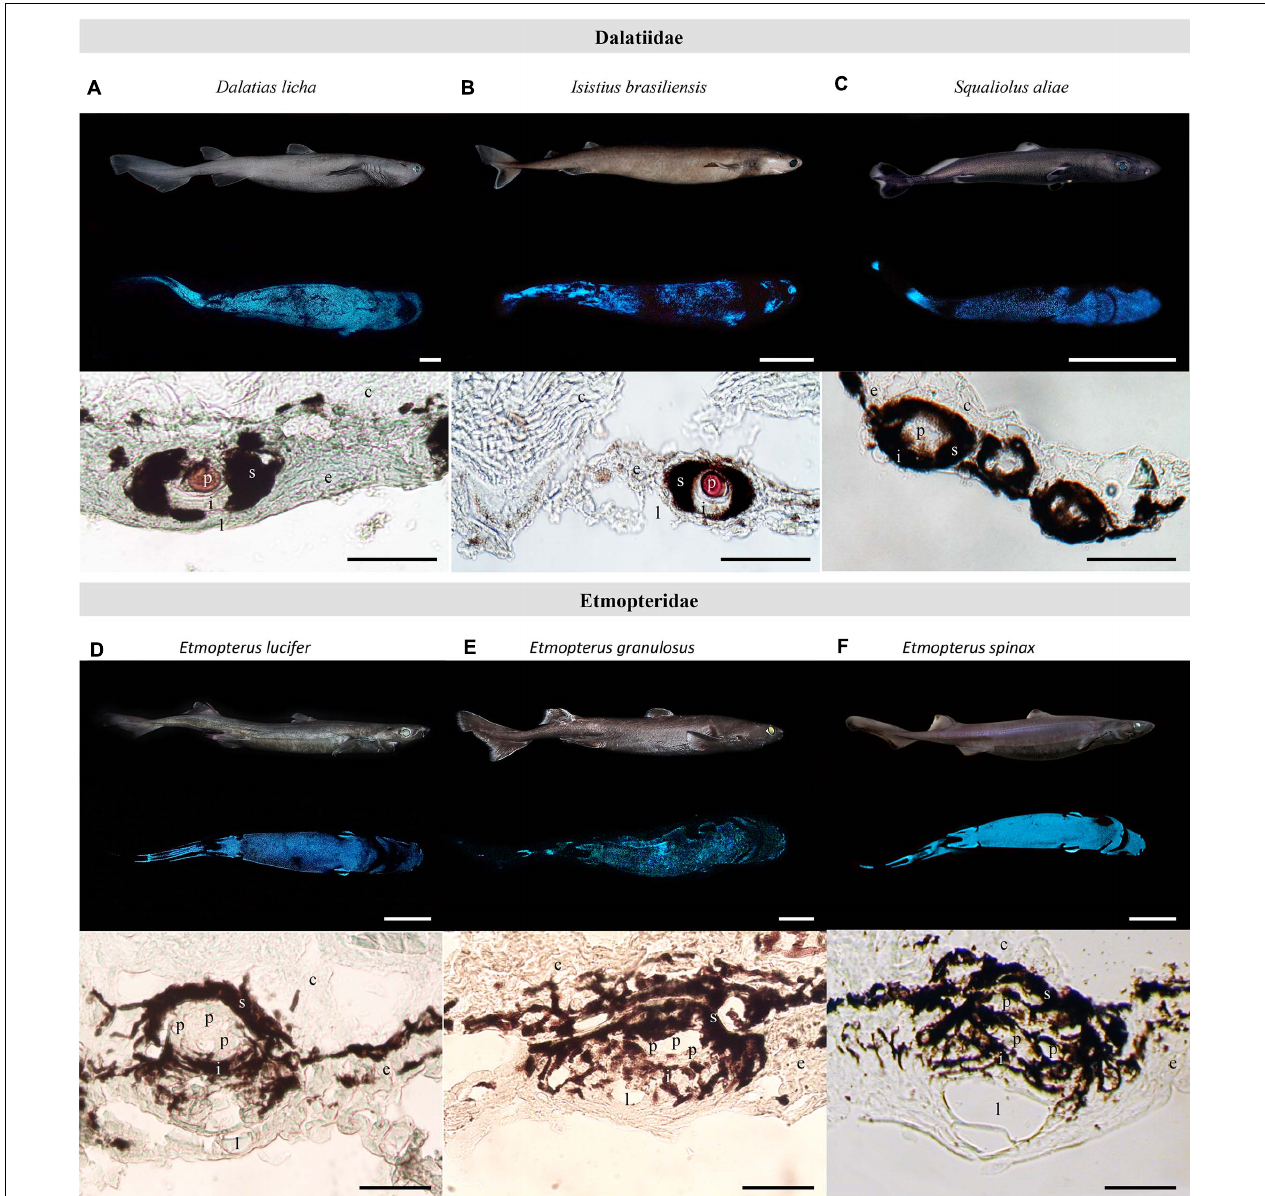
FIGURE 2 | Dalatiidae and Etmopteridae ventral luminous pattern and photophore histology. Picture of the lateral side in daylight, ventral luminescent pattern and section across ventral integument photophore of (A) Dalatias licha , (B) Isistius brasiliensis , (C) Squaliolus aliae , (D) Etmopterus lucifer , (E) Etmopterus granulosus , and (F) Etmopterus spinax . Ventral luminescence in dalatiid shows a homogenous pattern, while etmopterids show a heterogenous pattern with different zones. Photophores histology highlights a single photocyte within small photophores in dalatiids, while etmopterids harbor bigger and more complex photophores. c, connective tissue; e, epidermis; i, iris-like structure cells; l, lens cell; p, photocyte; s, pigmented sheath. In toto shark picture scale bar: 10 cm; photophore section scale bar: 100 µ